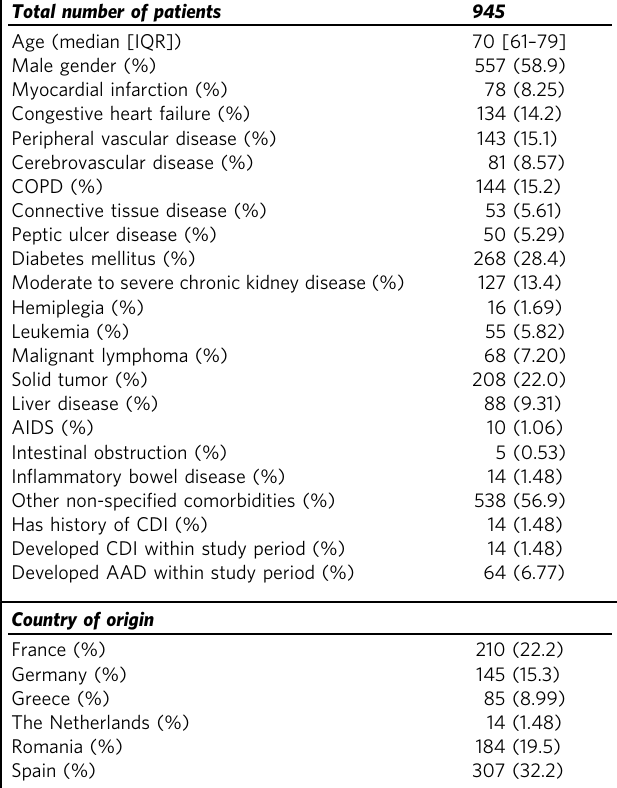
Table 1 Patient demographics of the analyzed study